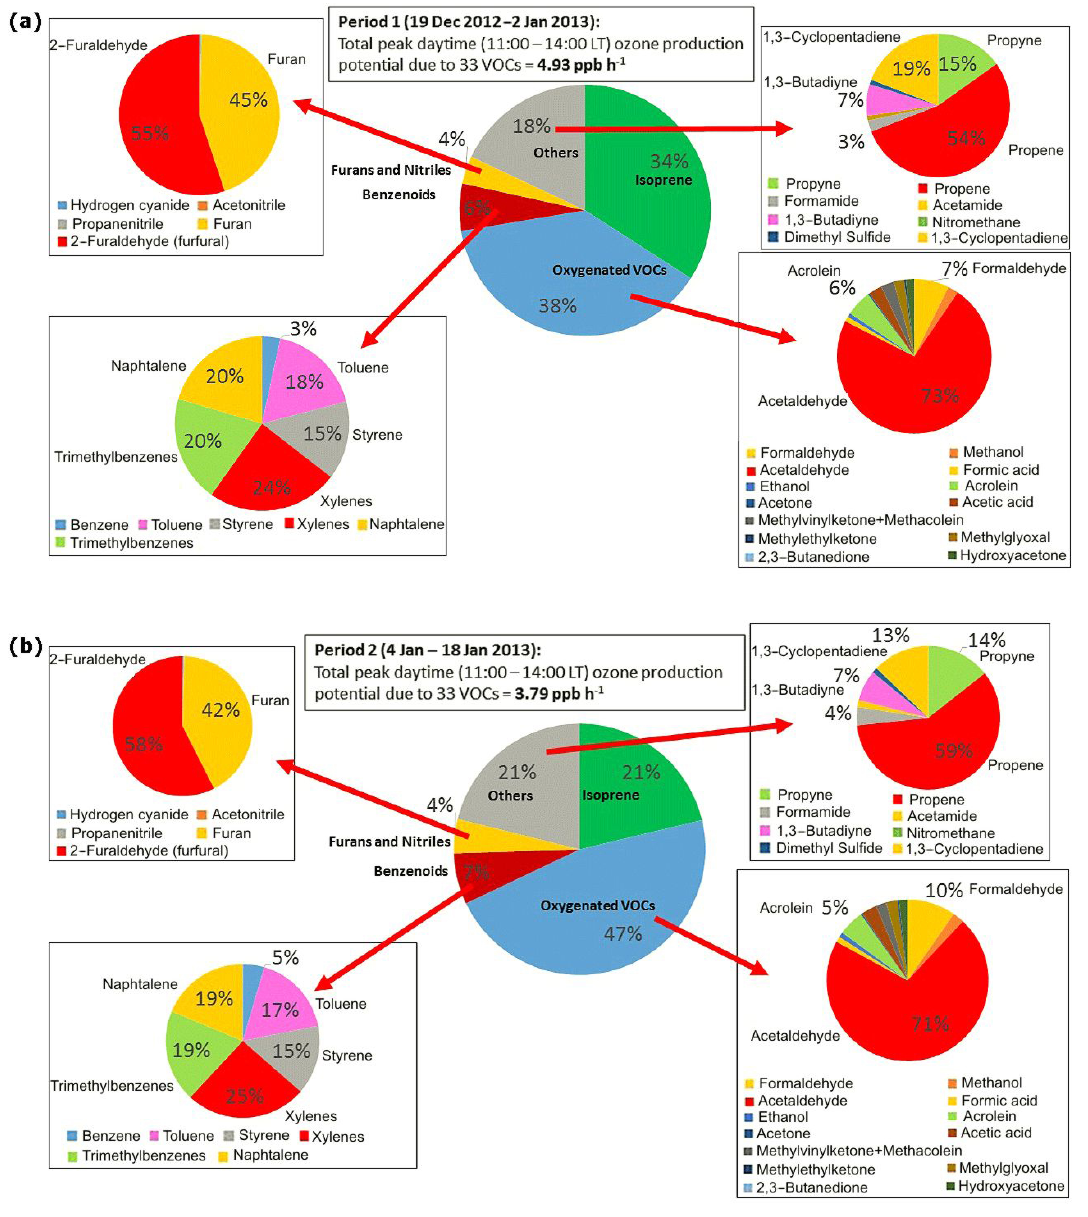
Figure 10. Pie charts showing contribution of different class of compounds to total ozone formation potential for (a) period 1 (19 December 2012–2 January 2013) and (b) period 2 (4–18 January